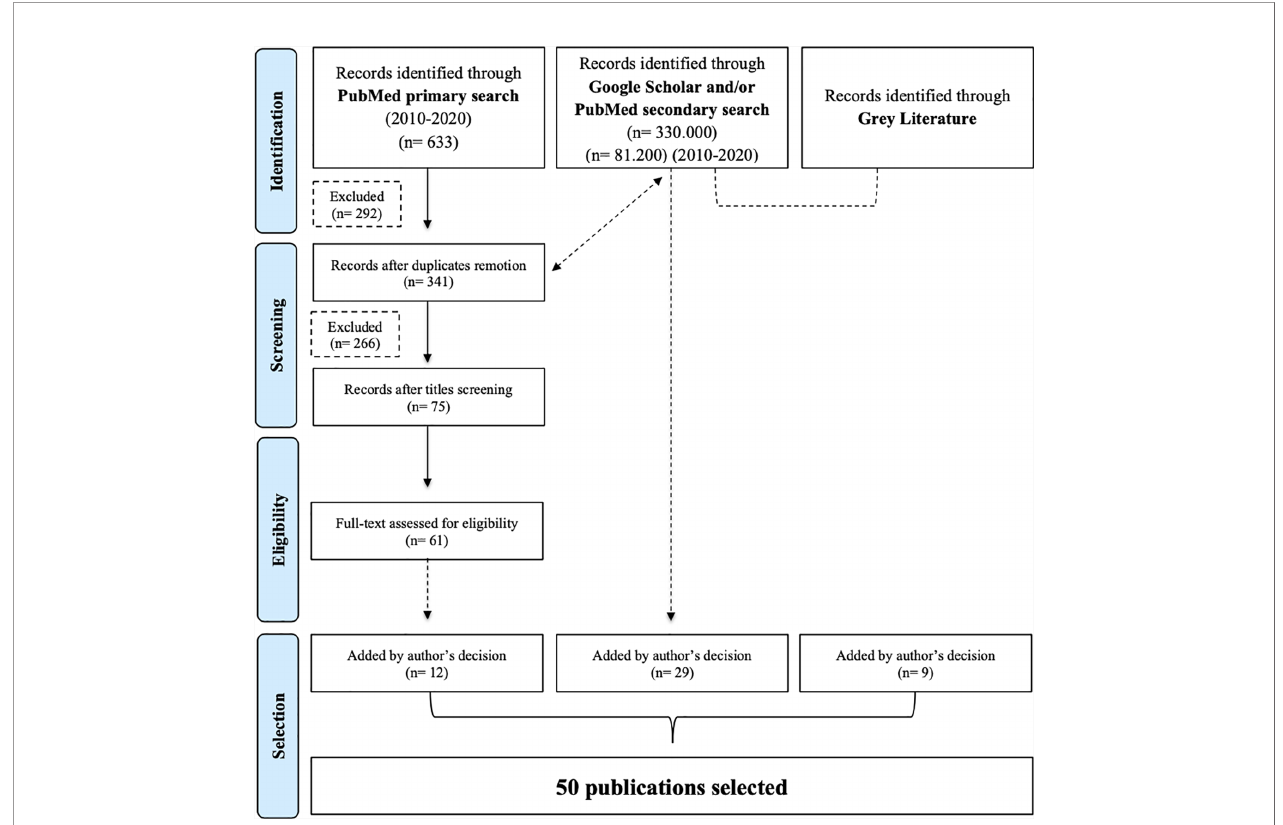
FIGURE 1 | Flowchart explaining the article selection strategy (adapted from PRISMA,